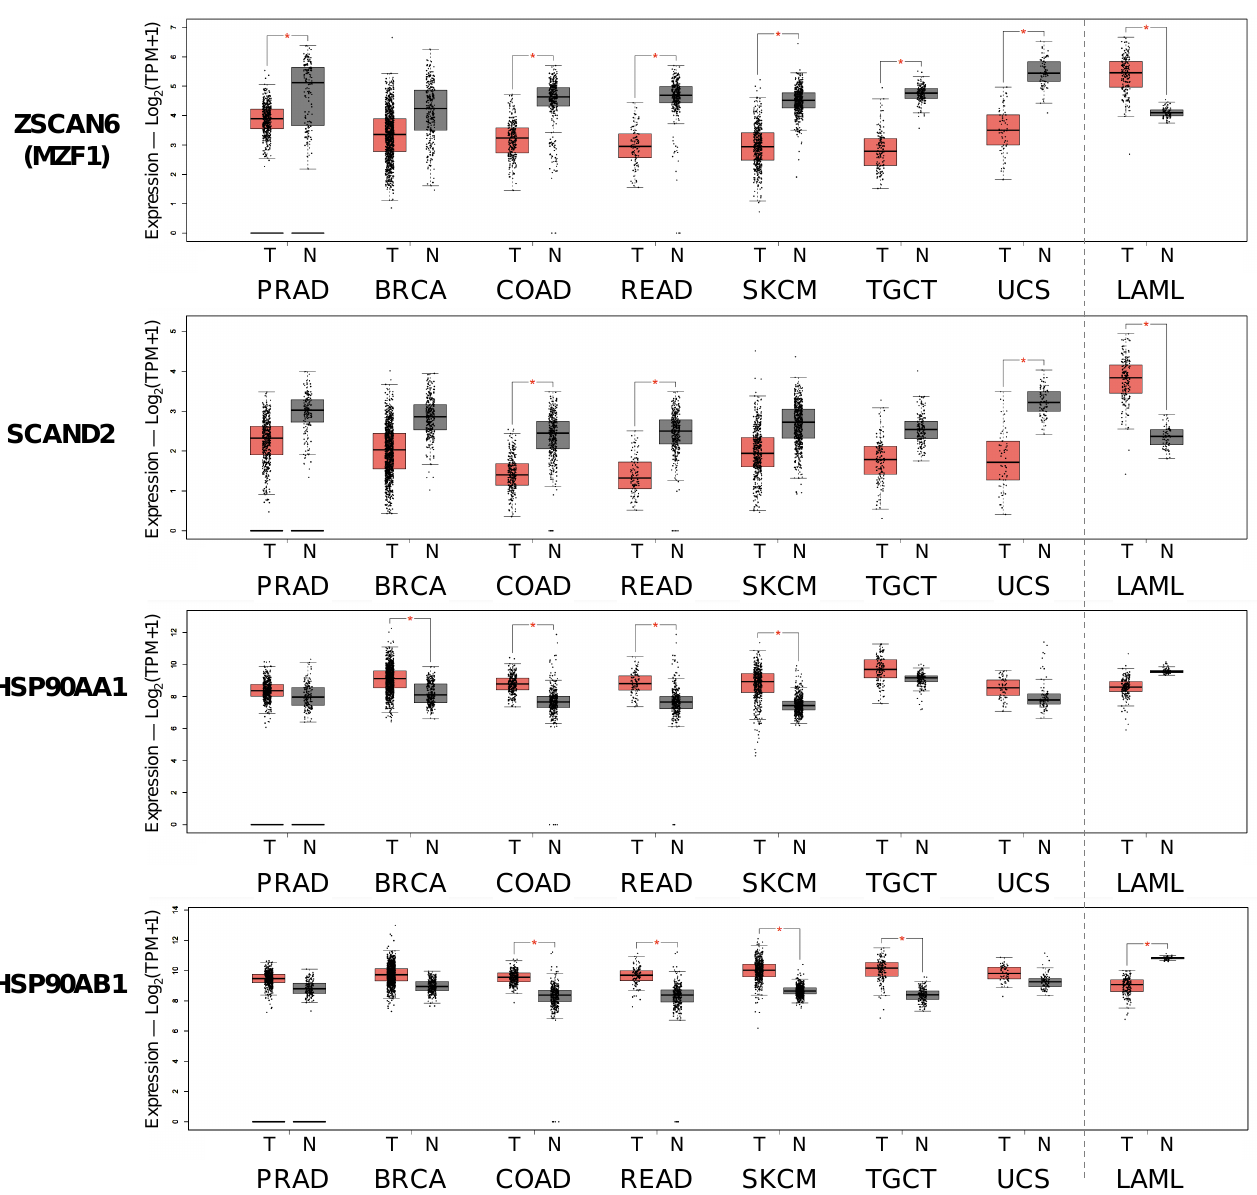
Figure 7. Gene expression levels of ZSCAN6(MZF1), SCAND2 , and HSP90 in various tumor types vs. paired normal tissues. Red box, tumor tissues (T). Gray box, normal tissues (N). Prostate adenocarcinoma (PRAD), breast invasive carcinoma (BRCA), colon adenocarcinoma (COAD), rectum adenocarcinoma (READ), skin cutaneous melanoma (SKCM), testicular germ cell tumors (TGCT), uterine carcinosarcoma (UCS), and acute myelo1id leukemia (LAML). Patient-derived clinical samples from TCGA PanCancer Atlas and GTEx were analyzed using GEPIA2. * p <